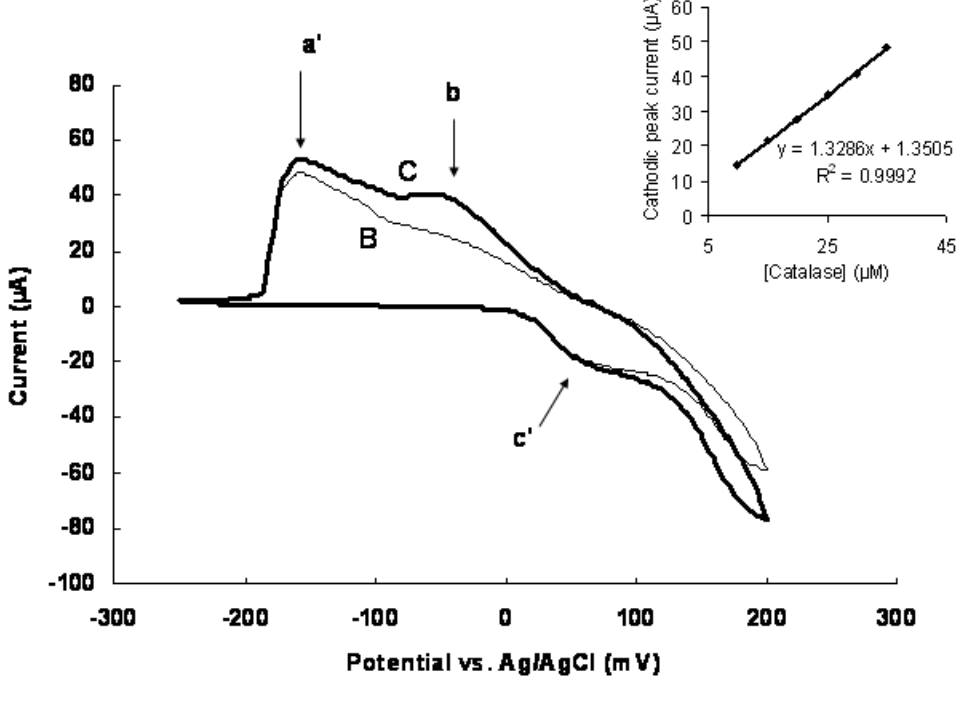
Figure 5. Cyclic voltammograms of silver electrode in a solution of 0.1 M KNO and: (B) 300 µM 3 bromide ions and 20 µM catalase (C) 300 µM bromide ions and 30 µM catalase. In this Figure, (a') and (c') represent the cathodic and anodic peaks of bromide ions in the solution with catalase; (b) represent cathodic peaks of catalase (scan rate 20 mV s -1 ). Inset shows the linear relationship of catalase concentration with its cathodic peak